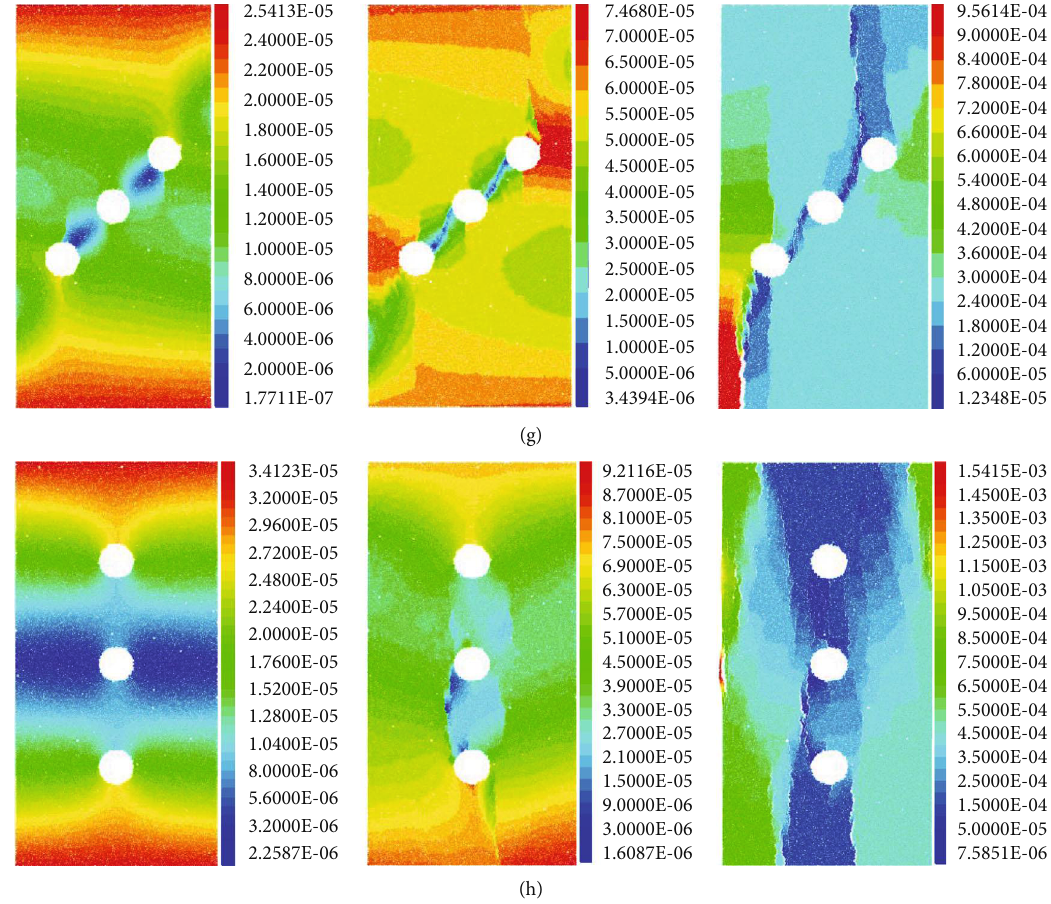
Figure 7: Variations in the displacement fi elds: (a) represents the intact model; (b – h) represent the NM-1 model to the NM-7 model,